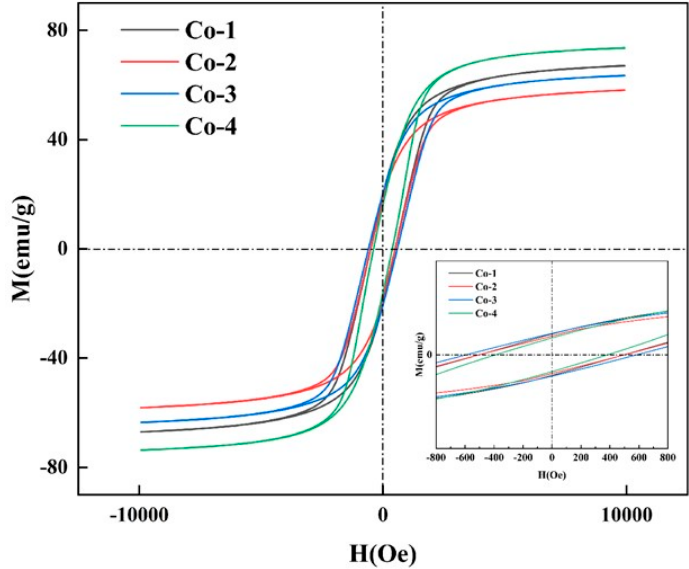
Figure 11. Magnetic hysteresis loops of Co-1, Co-2, Co-3, and Co-4. Figure 10. Magnetic hysteresis loops of Co-1, Co-2, Co-3, and Co-4.